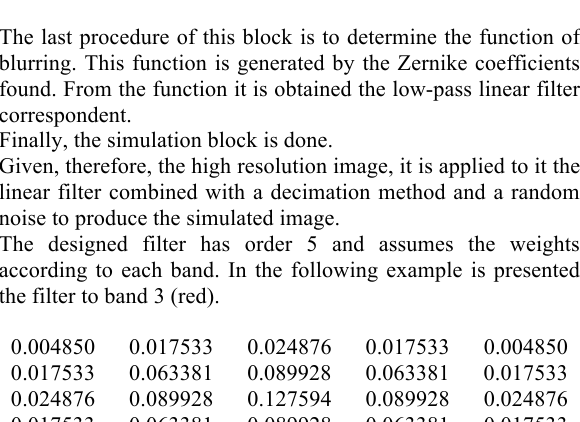
Figure 2. Application of the blurring function determined by the Zernike coefficients.